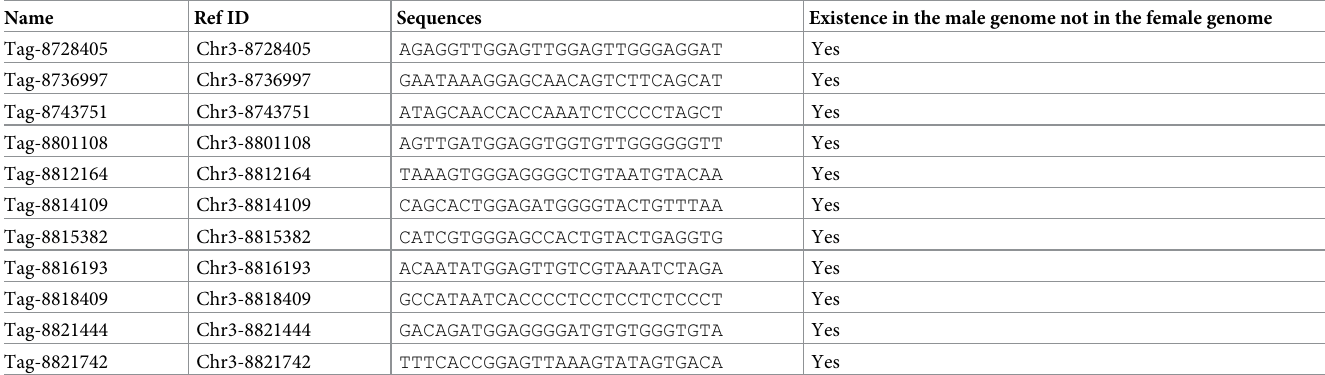
Table 2. Information of 11 male-specific 2b-RAD tags obtained from Alosa sapidissima